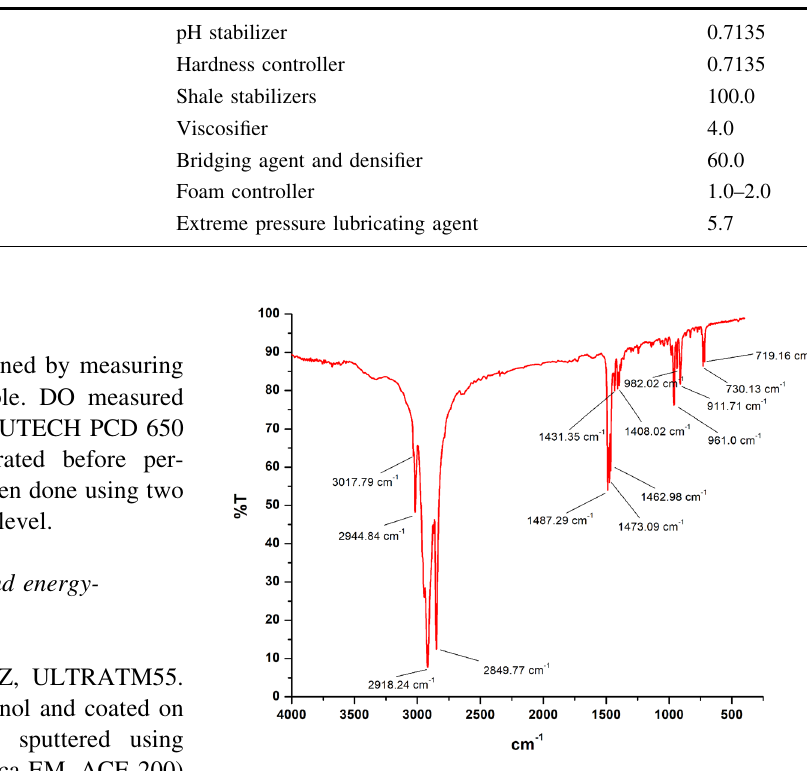
Fig. 1 FTIR spectrum of